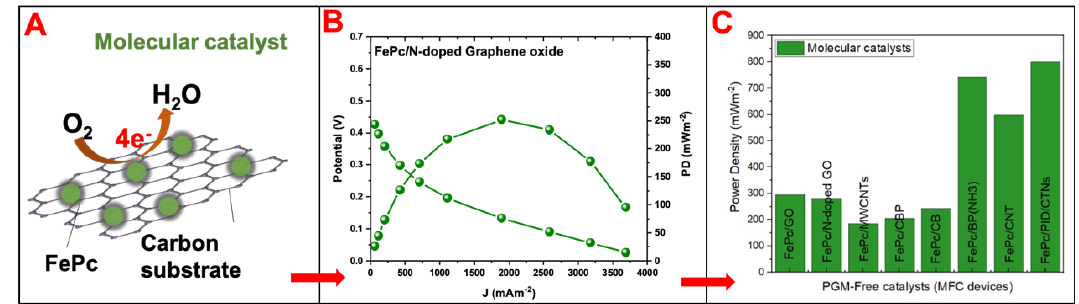
Figure 4. ( A ) Schematics of oxygen reduction reaction (ORR) at the surface of a molecular catalyst; ( B ) polarization and power density curves of FePc on N-doped graphene oxide in a single-chamber MFC; ( C ) MFC performance (maximum power density) of different types of molecular catalysts.